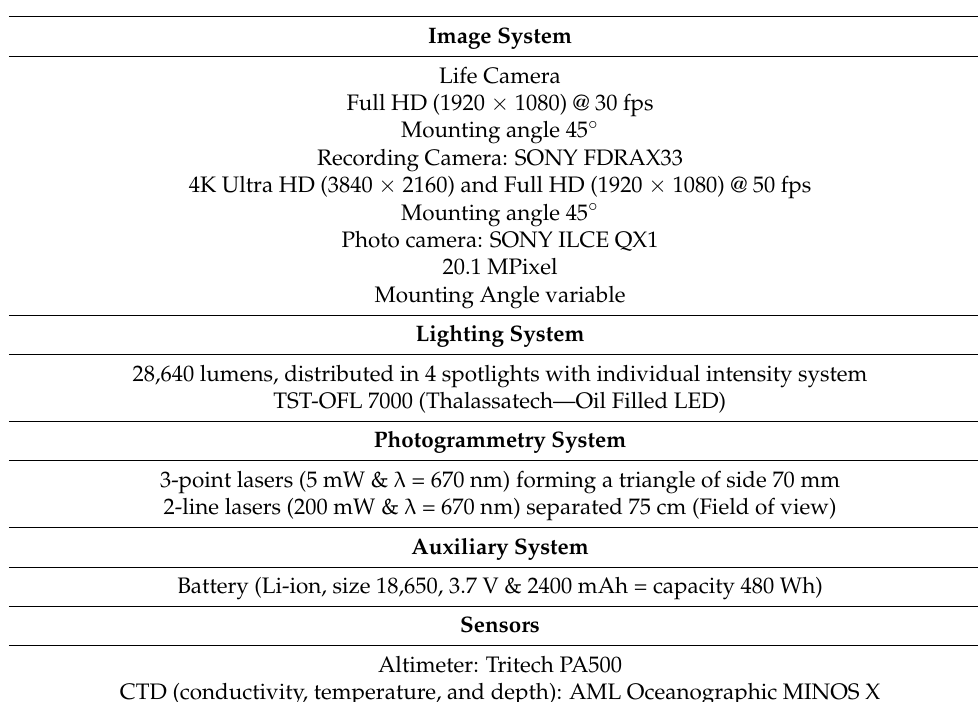
Figure 6. Sledge and equipment use in 2018 UWTV survey at the Gulf of Cadiz. Table 1. Equipment details used in data collection.